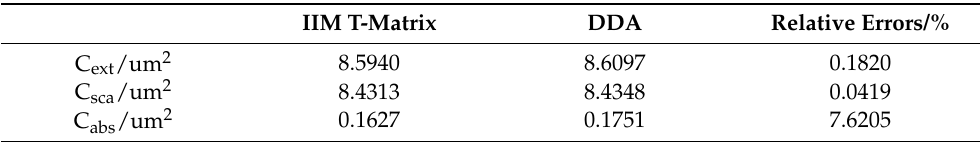
Table 1. The integral scattering properties of the hexagonal prism particles calculated by IIM T-matrix and DDA